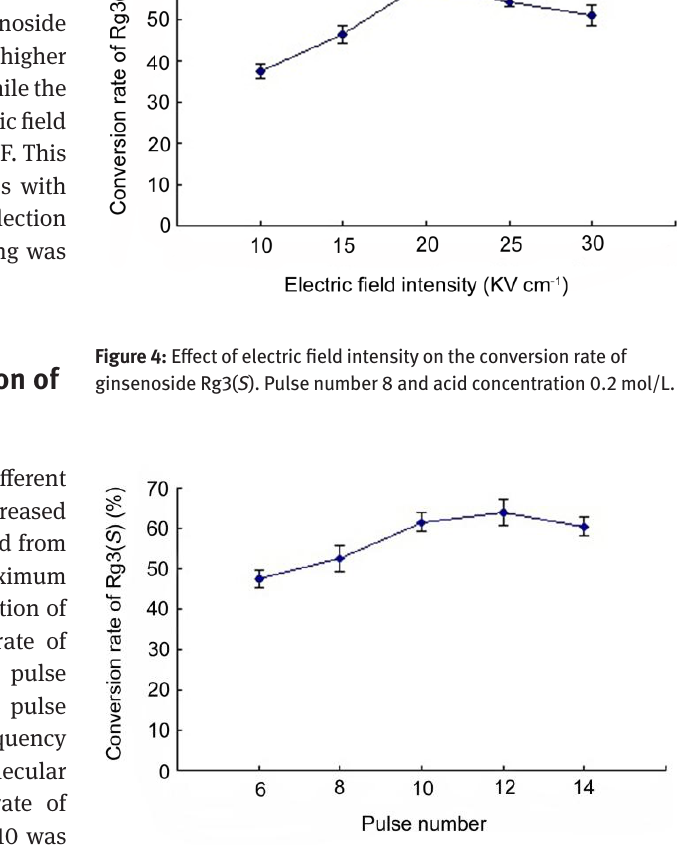
Figure 5: Effect of pulse number on the conversion rate of ginsenoside Rg3( S ). Electric field intensity 20 kVcm -1 and acid concentration 0.2